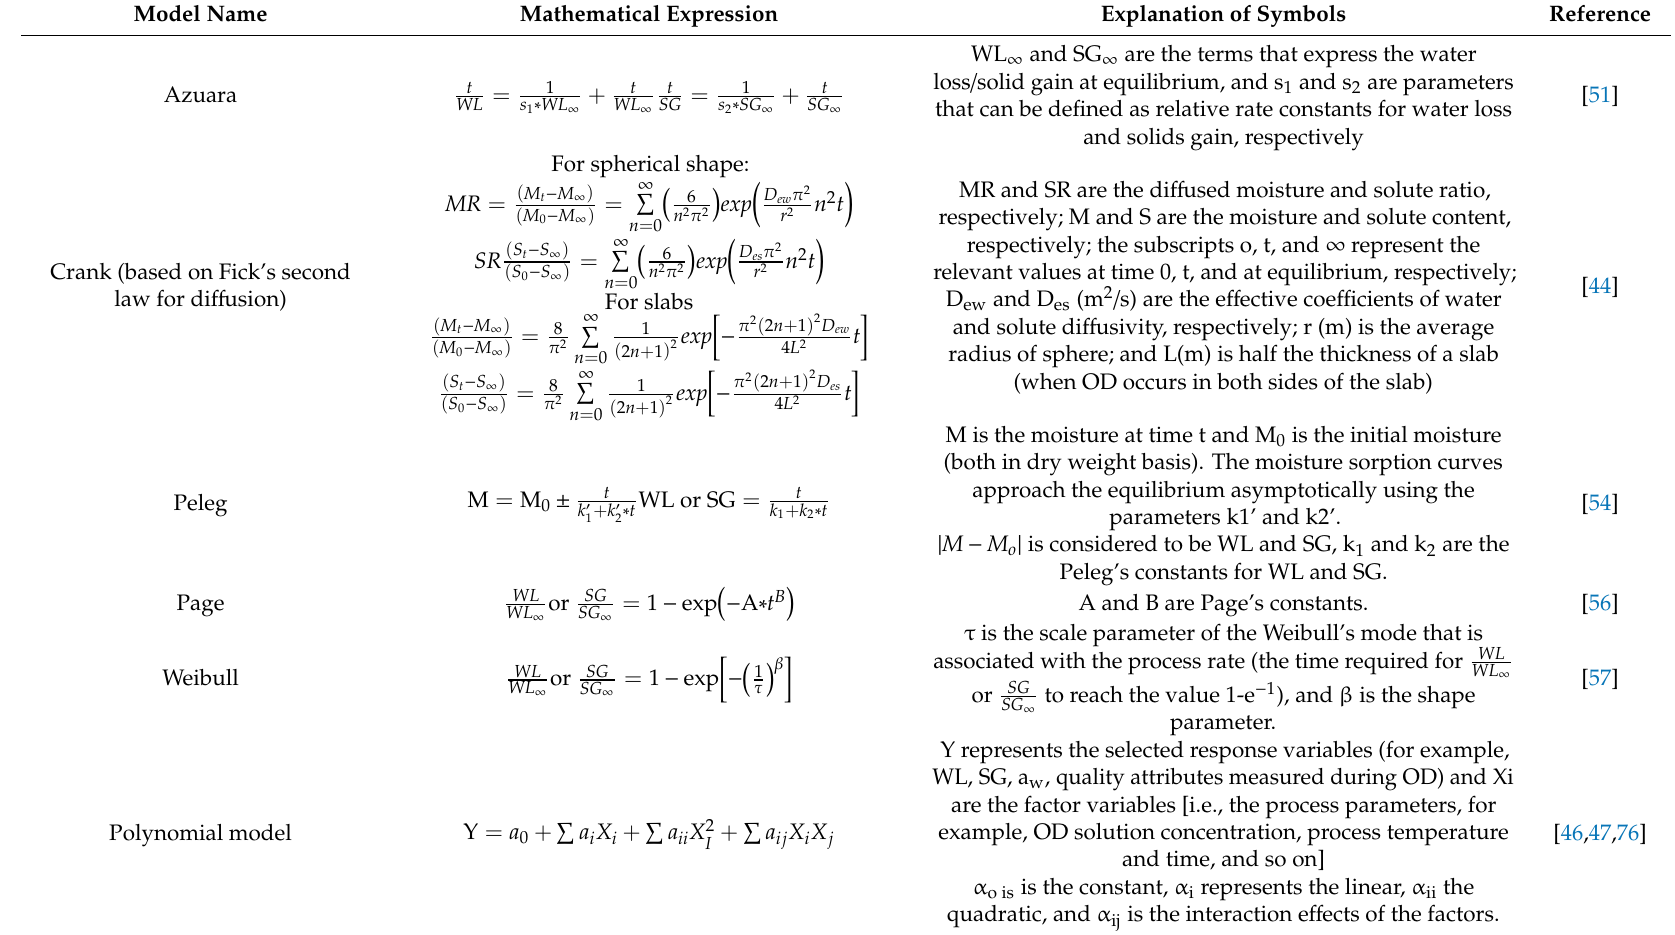
Table 2. Main equations of mathematical description of mass transfer phenomena during osmotic dehydration (as a preliminary step to subsequent